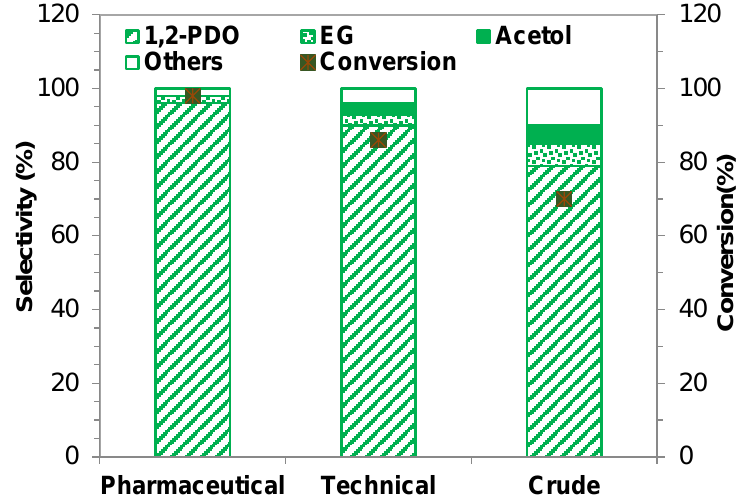
Figure 8. Influence of different grades of glycerol on glycerol conversion and product selectivities with 5Cu-1B/Al 2 O 3 catalyst (reaction conditions: 250 ◦ C, 10 wt% aq. glycerol feedstock, 6 MPa, WHSV 0.1 h − 1 ).